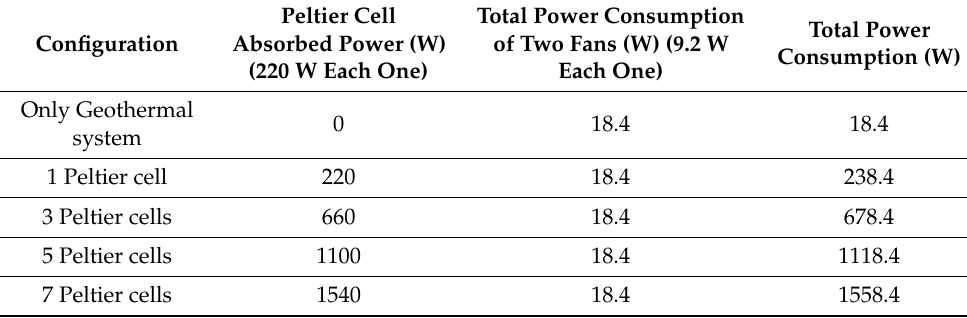
Table 9. Final electrical consumption of the